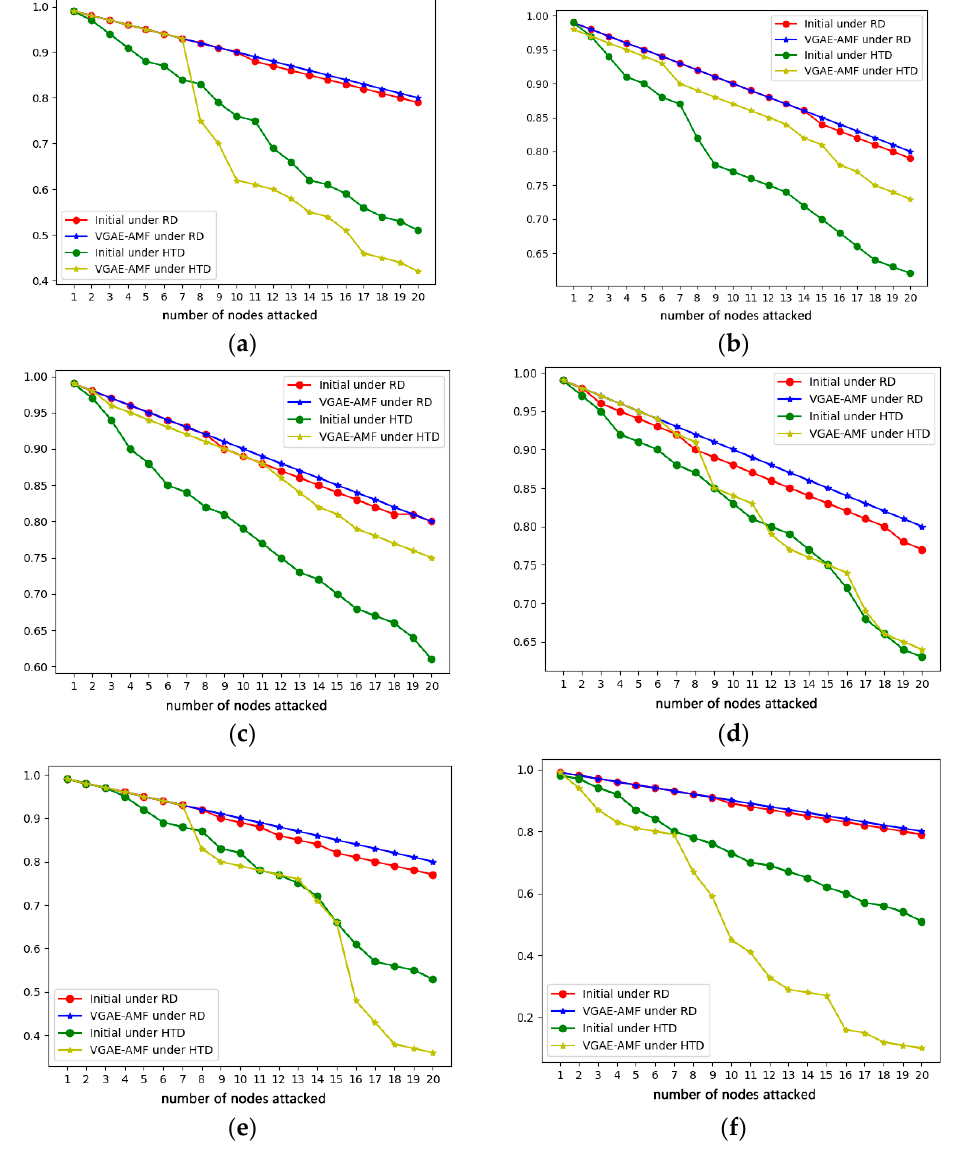
Figure 10. Effect of different value λ on algorithm optimization: ( a ) λ = 0.2; ( b ) λ = 0.3; ( c ) λ = 0.4; ( d ) λ = 0.5; ( e ) λ = 0.6; ( f ) λ =